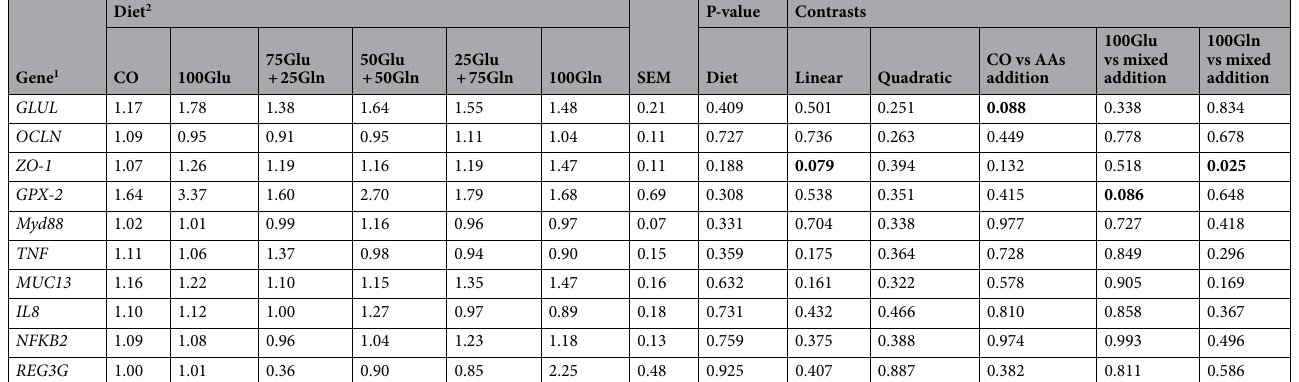
Table 5. Effect of the dietary supplementation (6 g/T) with glutamate and glutamine in the different ratios on the jejunal gene expression of piglets at 8 days post-weaning. Gene 1 : Glutamate-Ammonia Ligase ( GLUL ); Occludin ( OCLN ); Tight Junction Protein 1 ( ZO-1 ); Glutathione Peroxidase 2 ( GPX -2); Innate Immune Signal Transduction Adaptor ( MyD88 ); Tumor Necrosis Factor ( TNF ); Mucin 13 Cell Surface Associated ( MUC13 ); C-X-C Motif Chemokine Ligand 8 ( IL8/ CXCL8 ); Nuclear Factor Kappa B Subunit 2 ( NFKB2 ); Regenerating Family Member 3 Gamma ( REG3G ). Diet 2 CO = standard diet; 100Glu = CO plus 6 kg/Ton Glu; 75Glu + 25Gln = CO plus 4.5 kg/Ton Glu and 1.5 kg/Ton Gln; 50Glu + 50Gln = CO plus 3 kg/Ton Glu plus 3 kg/Ton Gln; 25Glu + 75Gln = CO plus 1.5 kg/Ton Glu and 4.5 kg/Ton Gln; 100Gln = CO plus 6 kg/Ton Gln. Significant values are in